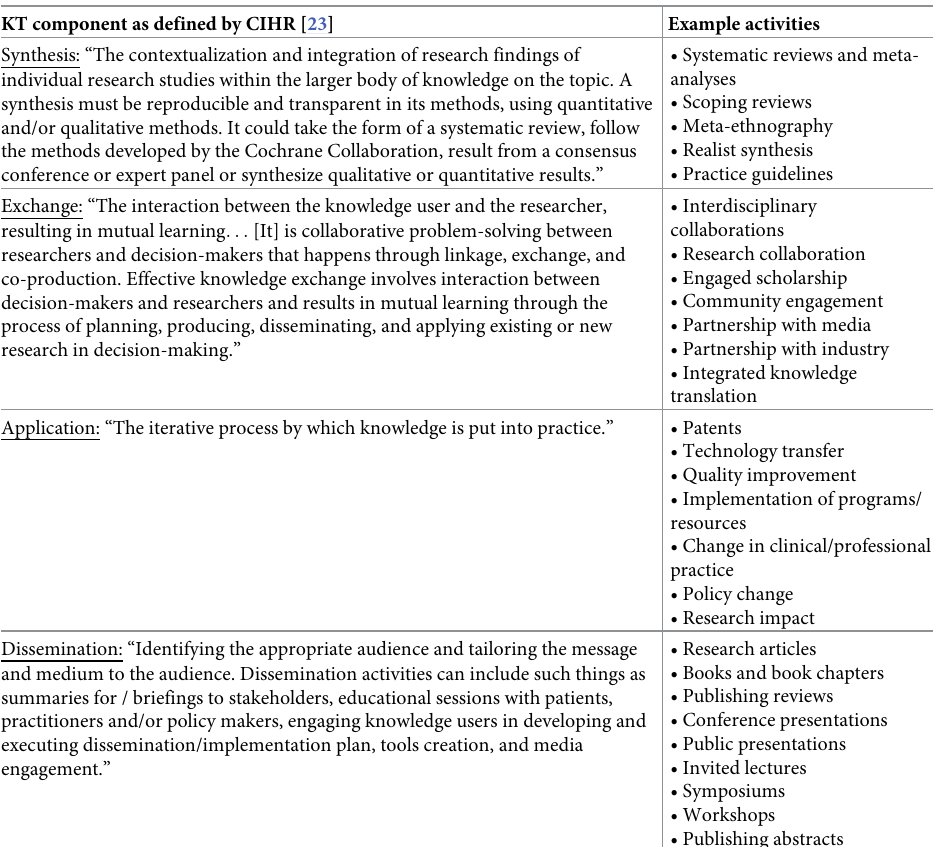
Table 1. Components of knowledge translation. KT component as defined by CIHR